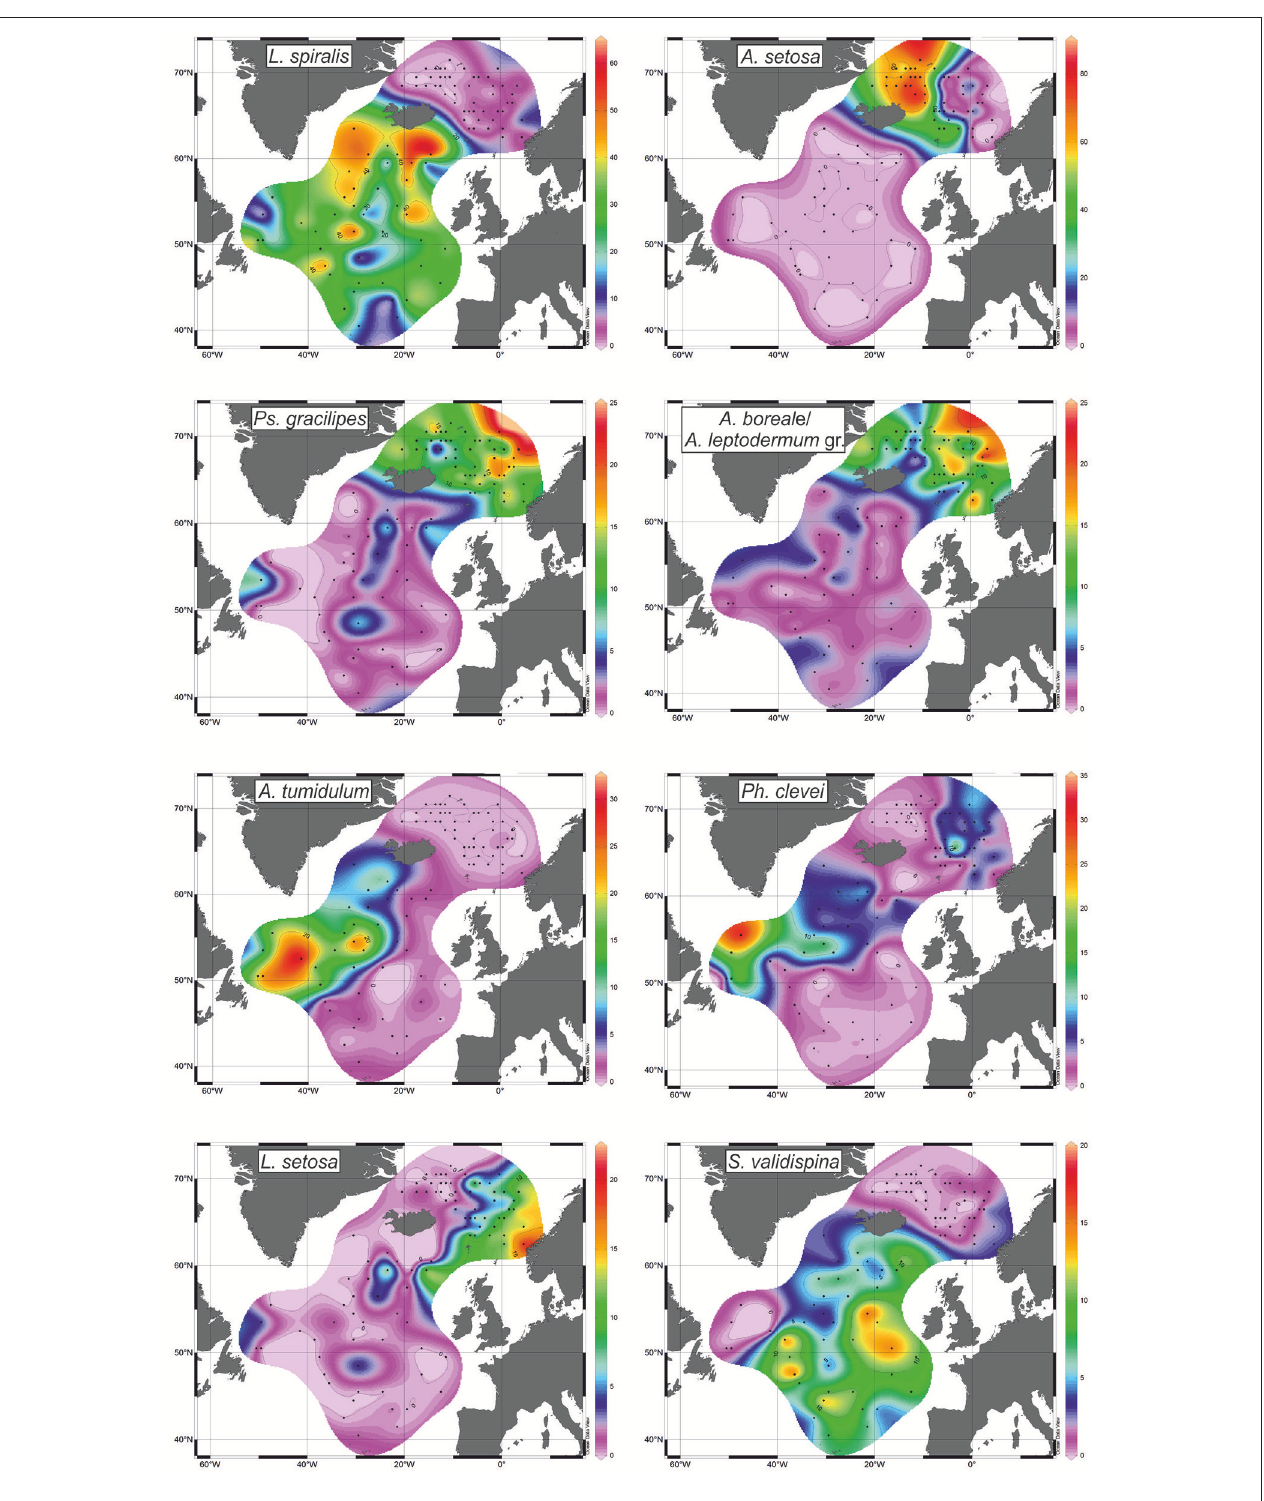
FIGURE 5 | Distribution of radiolarians (%) with the highest scores (see Figure 4 ).